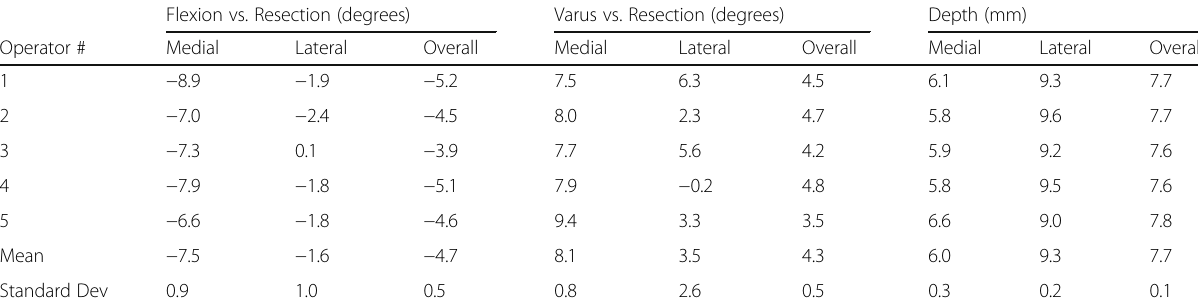
Table 2 Plane repeatability study for point selection process among five operators for a single patient case Flexion vs. Resection (degrees)